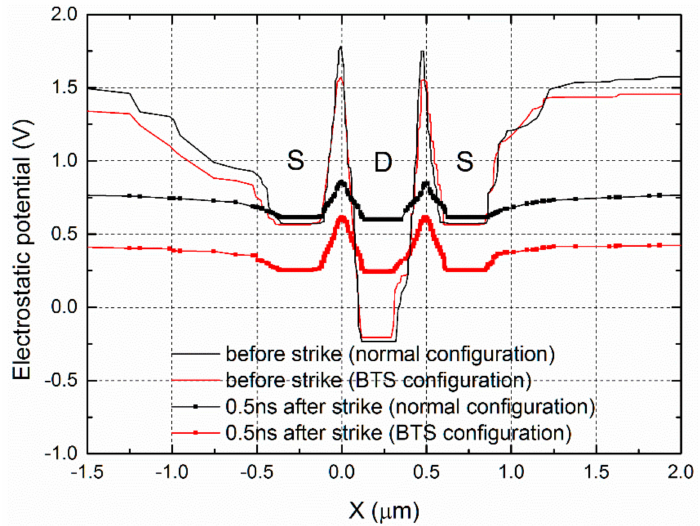
Figure 5. A 1-D profile of the PMOS electrostatic potential distribution underneath surface 10 nm with di ff erent N-well bias configurations (the struck transistor is modeled in two